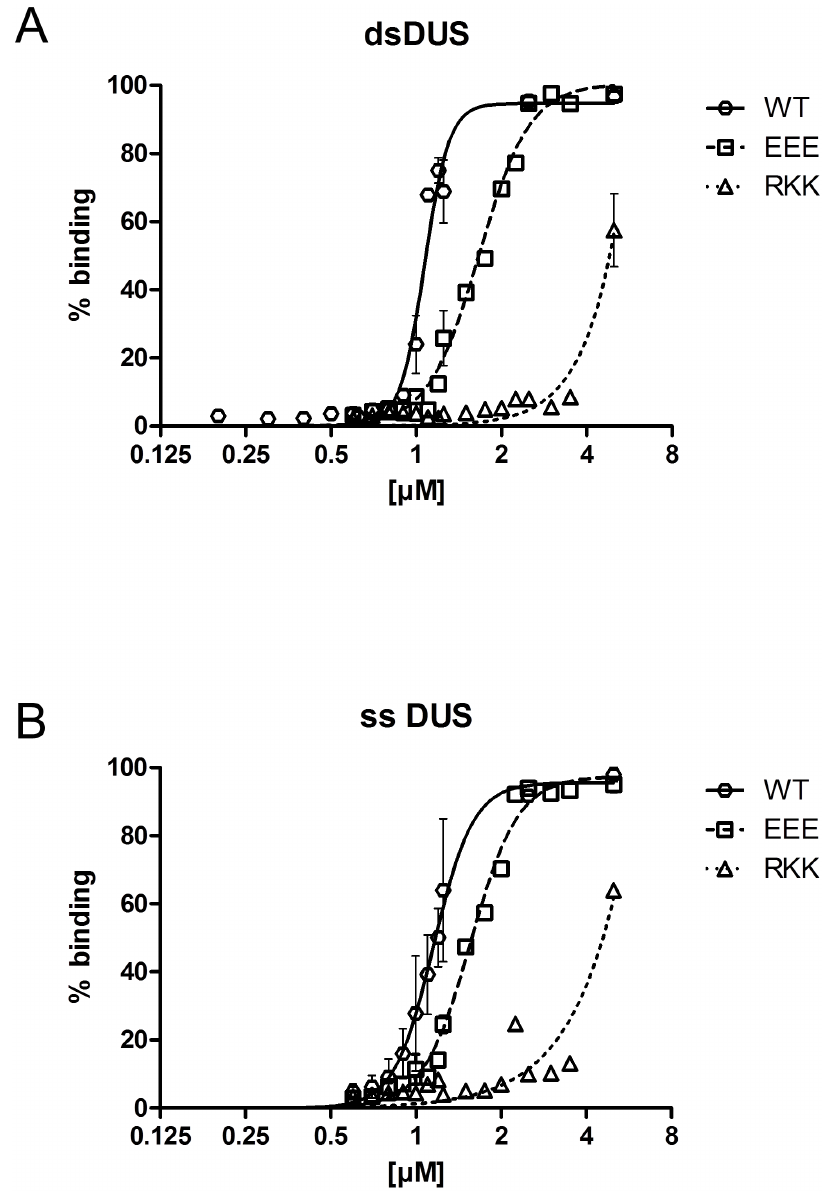
Fig 5. Defining the affinity of PilG to DNA. Plots showing the relative level of bound DNA substrate in EMSA at different protein concentrations of recombinant PilG FL (WT), PilG RKK43-45AAA (RKK), and PilG EEE39-41AAA (EEE) for (A) dsDNA and (B) ssDNA substrate. Shown are the cumulative data from (A) eight and (B) six gel runs and the non-linear fitting curves.